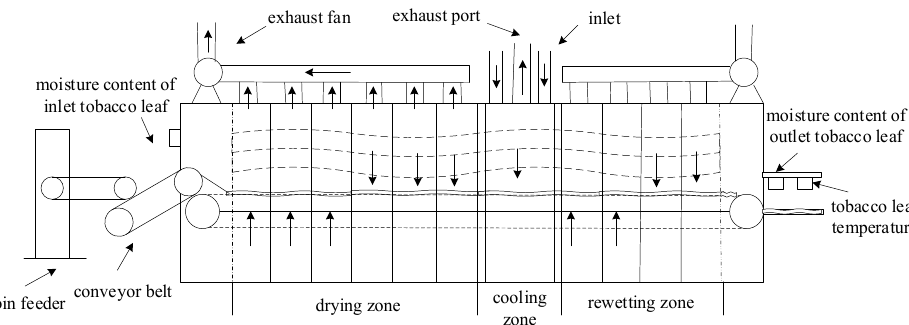
Figure 1. Schematic diagram of tobacco leaf redrying process.